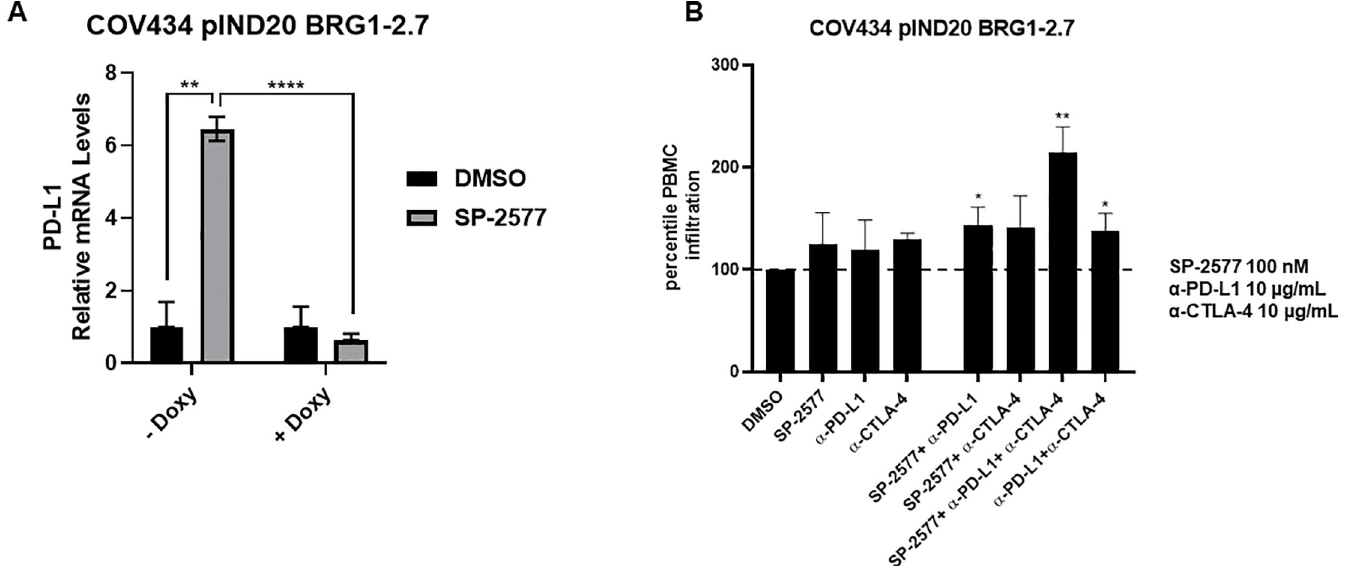
Fig 5. SP-2577 promotes PD-L1 expression and rescues checkpoint inhibition sensitivity in SCCOHT COV 434 pIND 20 BRG1-2.7 cell line. ( A ) RT-PCR analysis of COV434 pIND 20 BRG1-2.7 cells after SP-2577 treatment shows increase of PD-L1 expression levels, which are lost after doxycycline treatment. ( B ) Co-treatment of COV434 pIND 20 BRG1-2.7 organoids with SP-2577 and anti-PD-L1 antibodies or lymphocytes treated with anti-CTLA-4 antibodies showed an increase in lymphocyte infiltration as checked after 48 h.